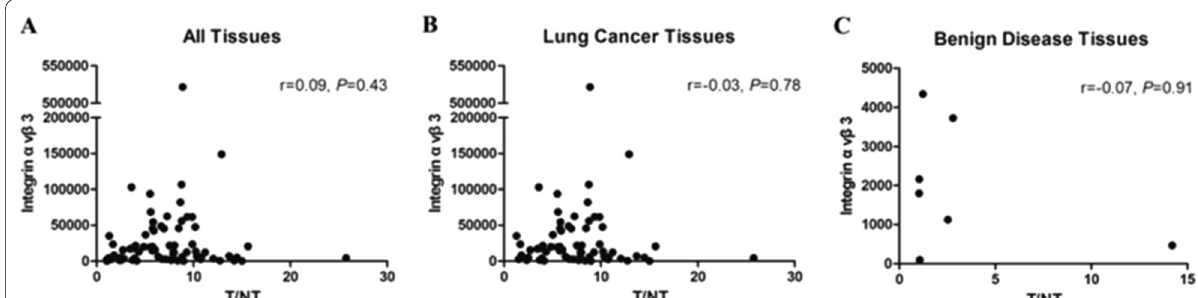
Fig. 7 The correlation analysis between ratio of primary tumour to normal tissue (T/NT) and α v β 3 expression in different groups